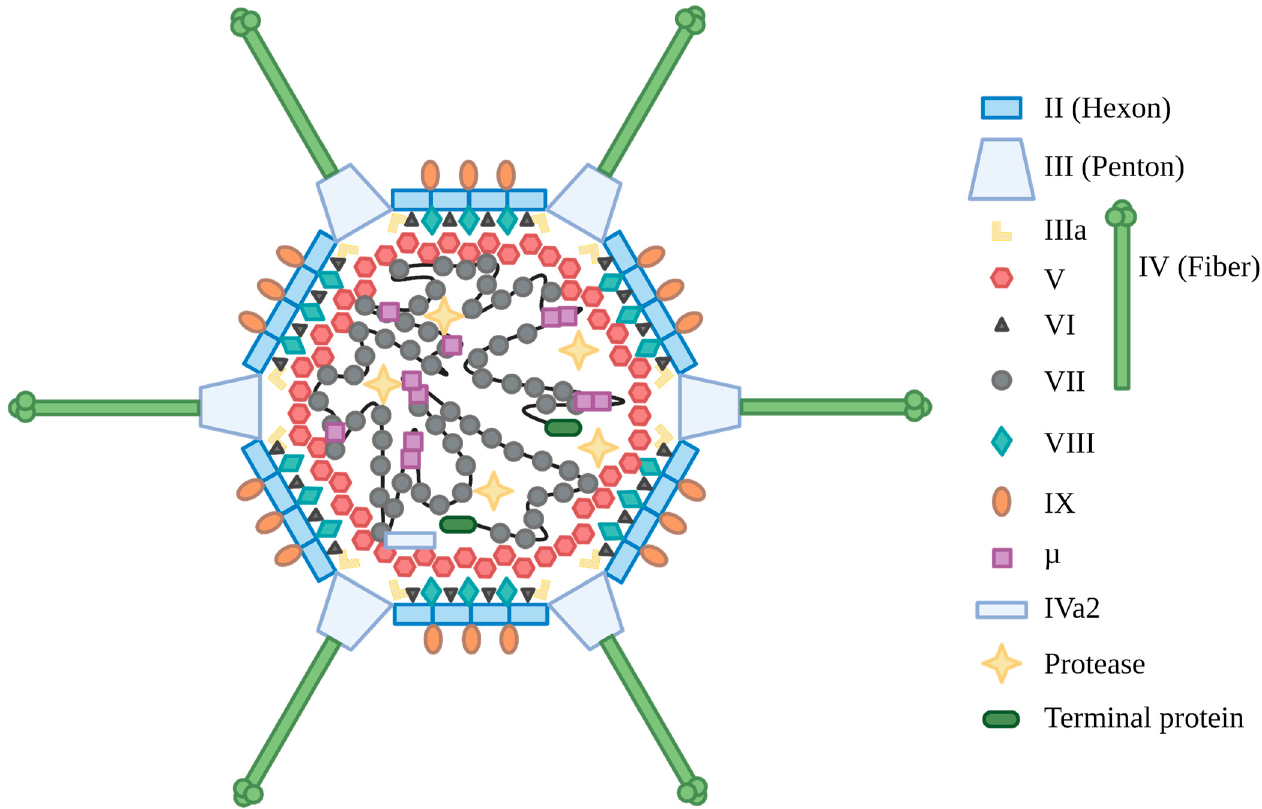
Figure 1. Schematic of the HAdV-5 virion. Adapted from [38], with modifications based on [33,39–41]. Created with BioRender.com.